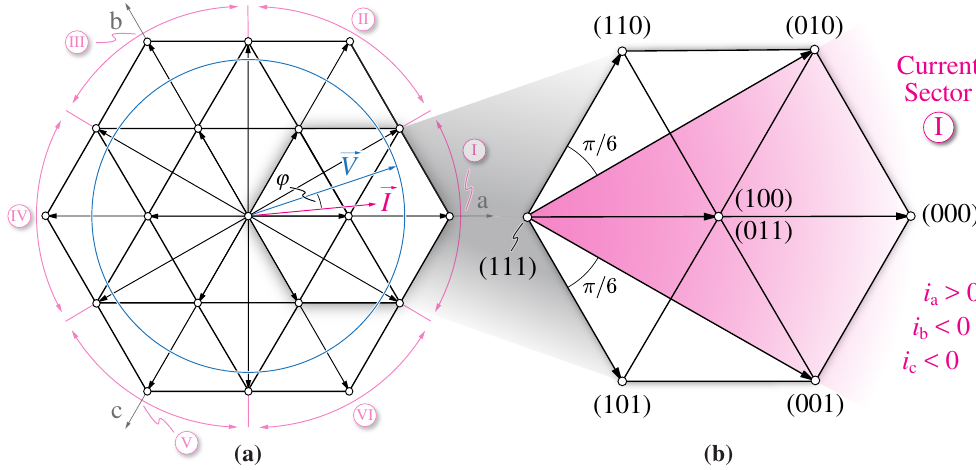
Figure 3. Complete space vector diagram of a three-phase three-level unidirectional rectifier. An overview of the 19 available space vectors, the 6 separate current sectors, the phase voltage vector (cid:126) V , the phase current vector (cid:126) I and the converter-side power factor angle ϕ is shown in ( a ). A focus on the voltage space vector hexagon available when (cid:126) I is transiting inside current sector I is provided in ( b ): the switching states are defined by the combination of the bridge-leg states, i.e., 0 when the 4Q switch is OFF and 1 when the 4Q switch is